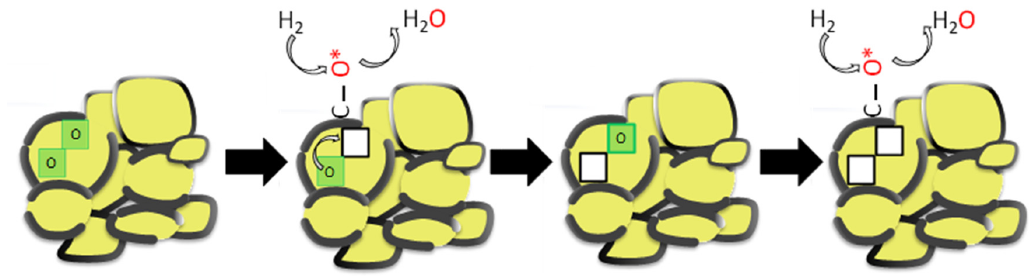
Figure 3. Oxygen storage capacity (OSC) results from thermal gravimetric analysis (TGA) analysis for different contact conditions.